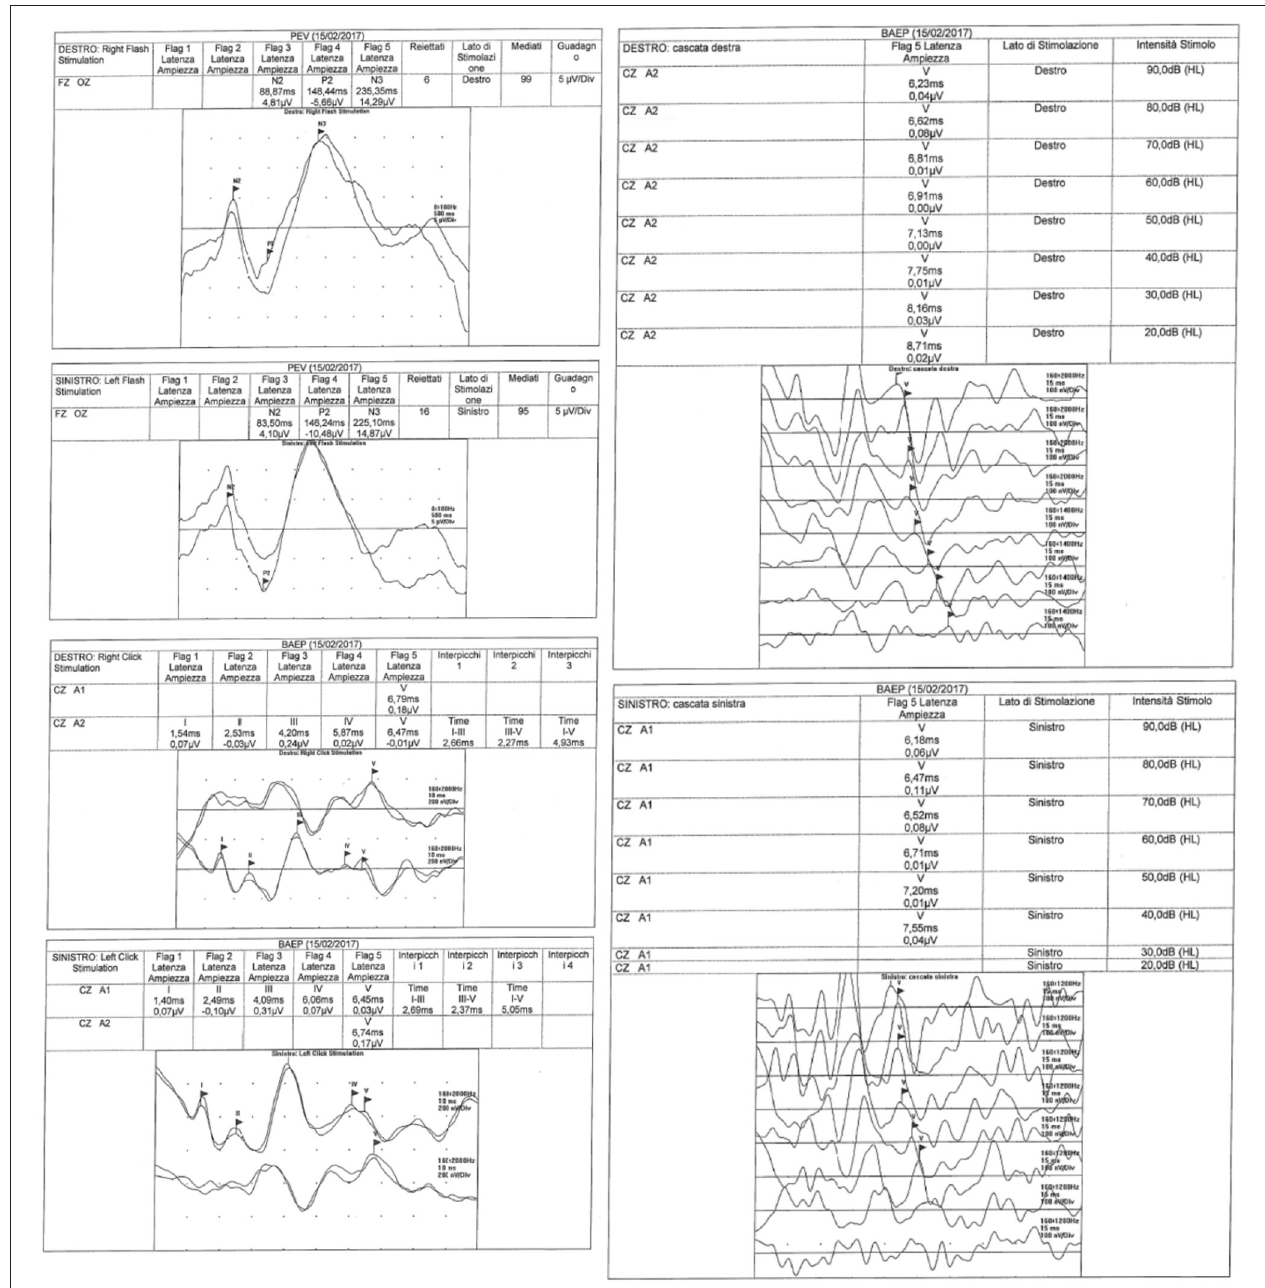
FIGURE 1 | VEPs and BAEPs in a patient with pathological records.